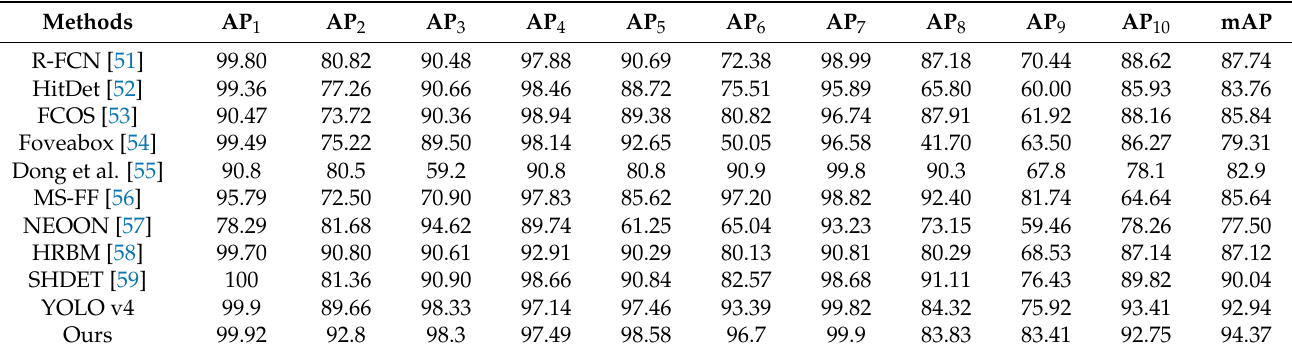
Table 3. Comparison results with other methods.